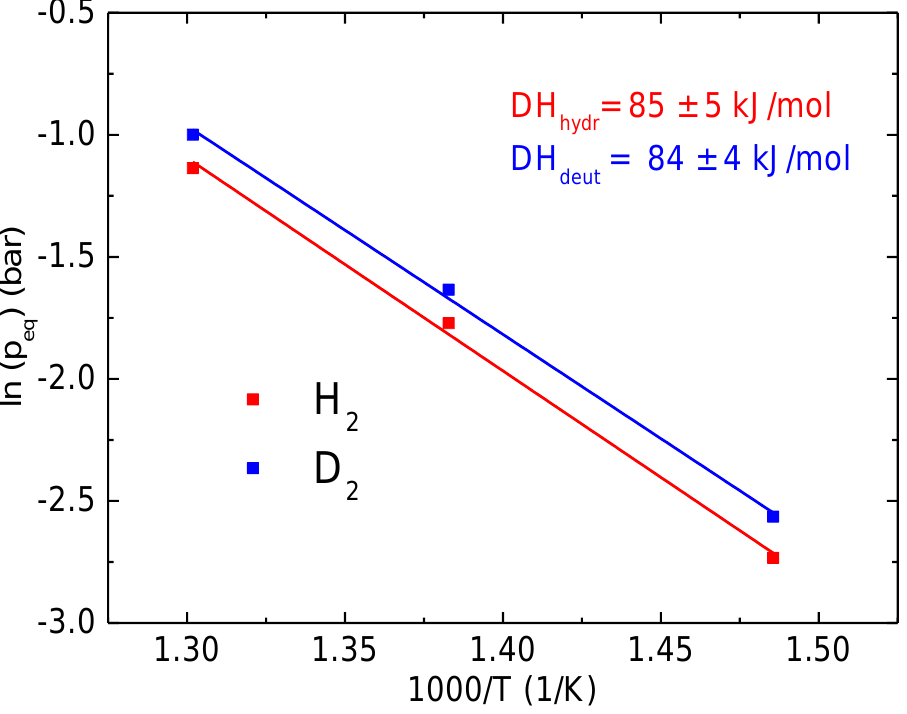
Figure 3. Van’t Hoff plot for Ni 33 Ti 39 Nb 28 at the fixed H(D)/M of 0.18 and best fit lines to calculate the hydrogenation/deuteration enthalpy.